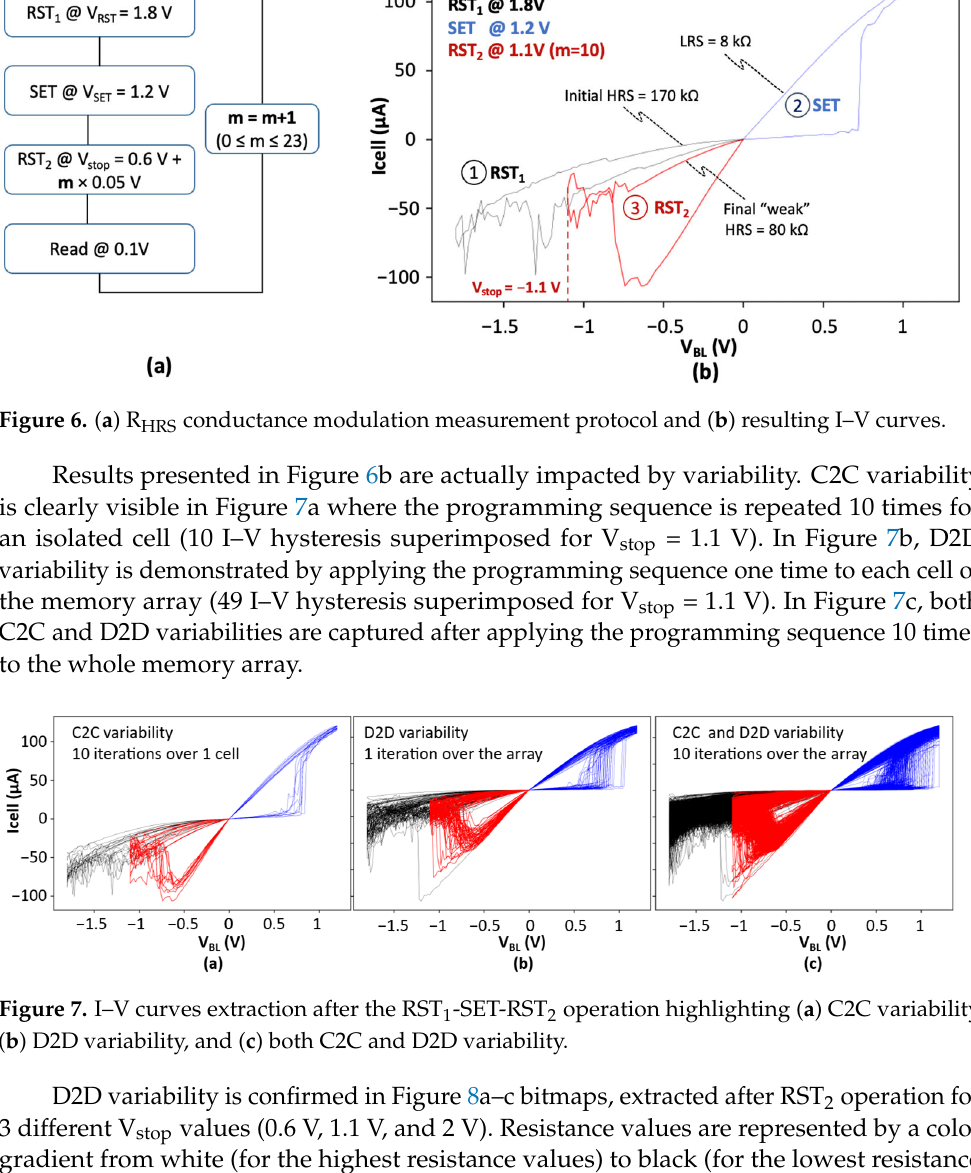
the first RST 1 operation, which results in a narrow hysteresis (black curve 1). From the resulting initial HRS state (170 k Ω ), a SET operation (blue curve 2) brings the cell in the LRS state (8 k Ω ). Finally, a “weak” RST operation, with V stop = 1.1 V is applied to bring